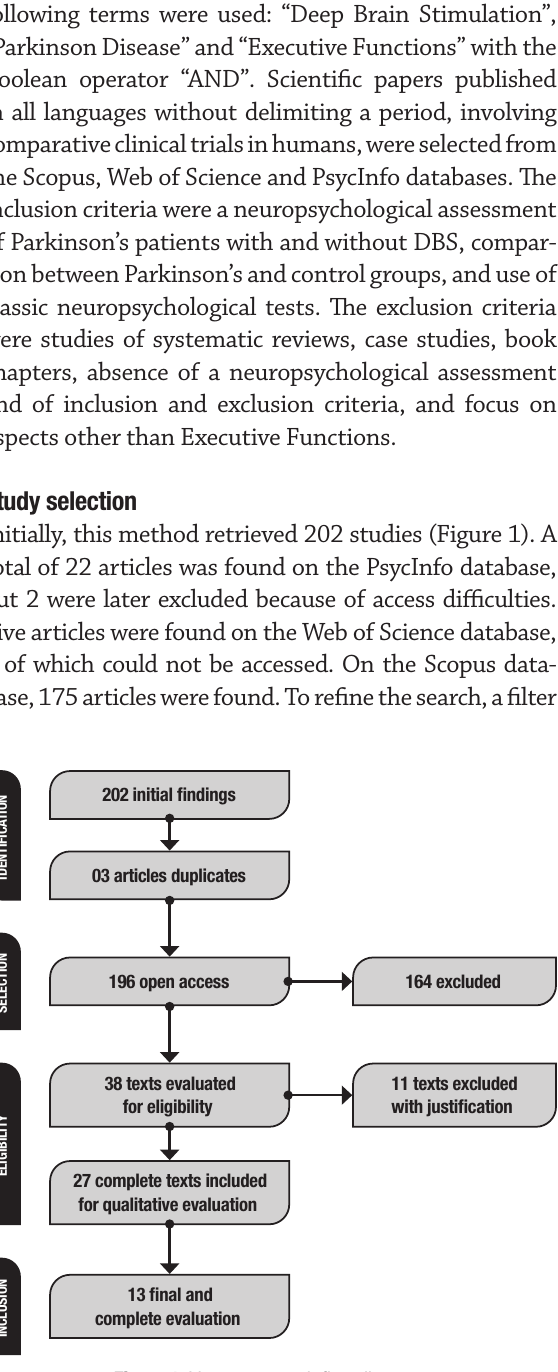
Figure 1. Literature search flow